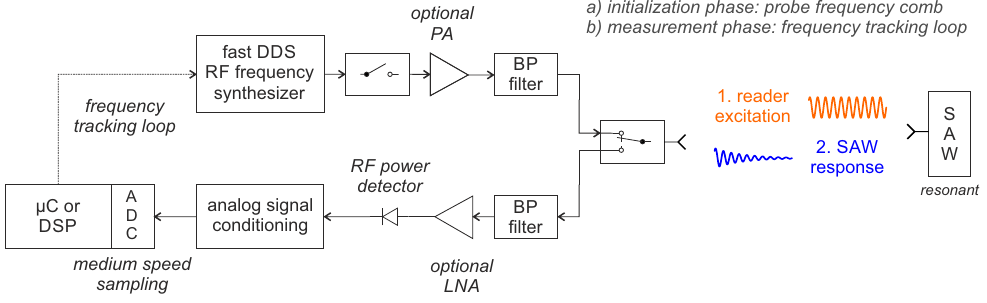
Figure 12. Block diagram of the reader concept for time domain sampling with pulsed frequency modulation (FM)/amplitude modulation (AM) tracking